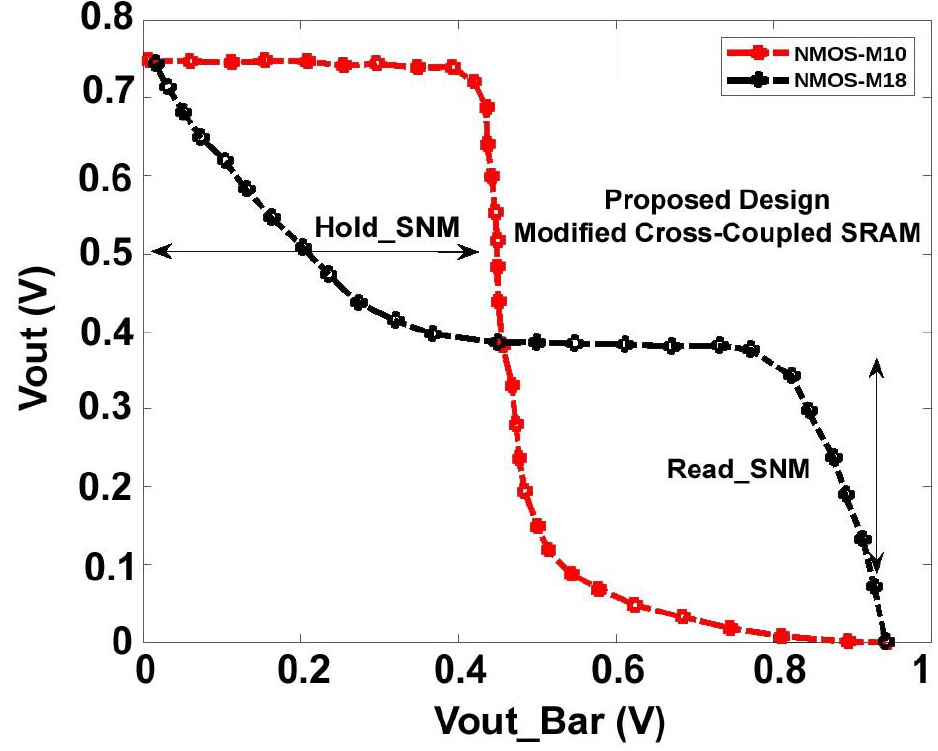
Figure 20. Hold and Read Static Noise Margin (SNM) of Proposed Sense Amplifier.